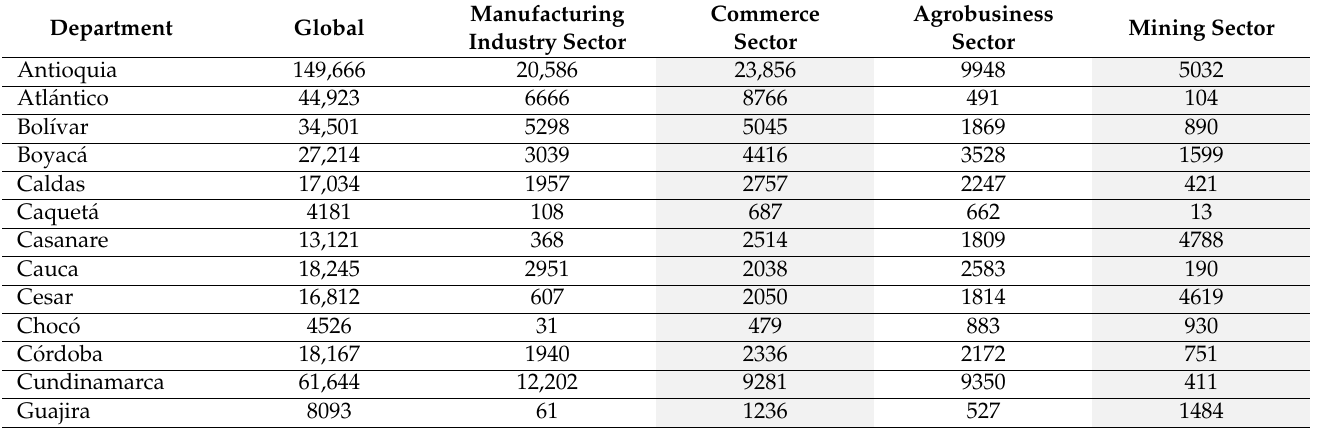
Table A8. Colombia departments’ GDP 2020: global and some sectors. Values in thousands of millions